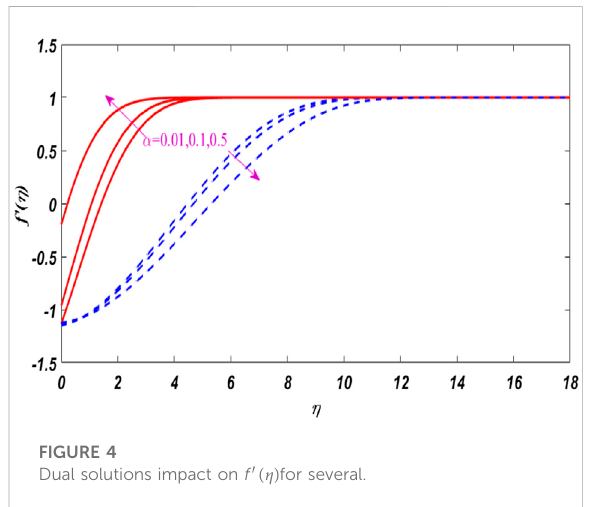
FIGURE 6 Dual solutions impact on for